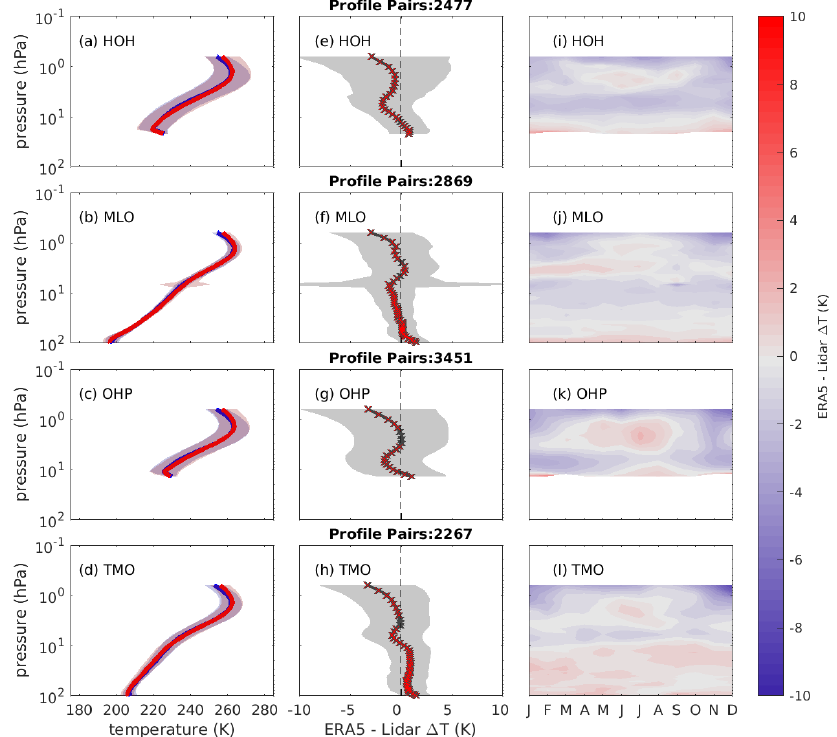
Figure 4. Mean profiles of matched temperatures from ERA5 (blue) and Rayleigh temperature lidar (red) positioned at (a) Hohenpeissenberg, (b) Mauna Loa, (c) Observatoire de Haute-Provence and (d) Table Mountain Observatory between 1990 and 2017. Shading depicts 1 standard deviation in the mean temperature. The vertical profiles of the mean of the differences between ERA5 and each lidar shown in (a–d) are shown in (e–h) respectively; shading shows 1 standard deviation of mean difference. Crosses are red for model levels where the mean of the differences are different from zero at the 95% significance level. Panels (i–l) show the temperature differences as a function of month and pressure level for each of the lidars shown in panels (a–d)